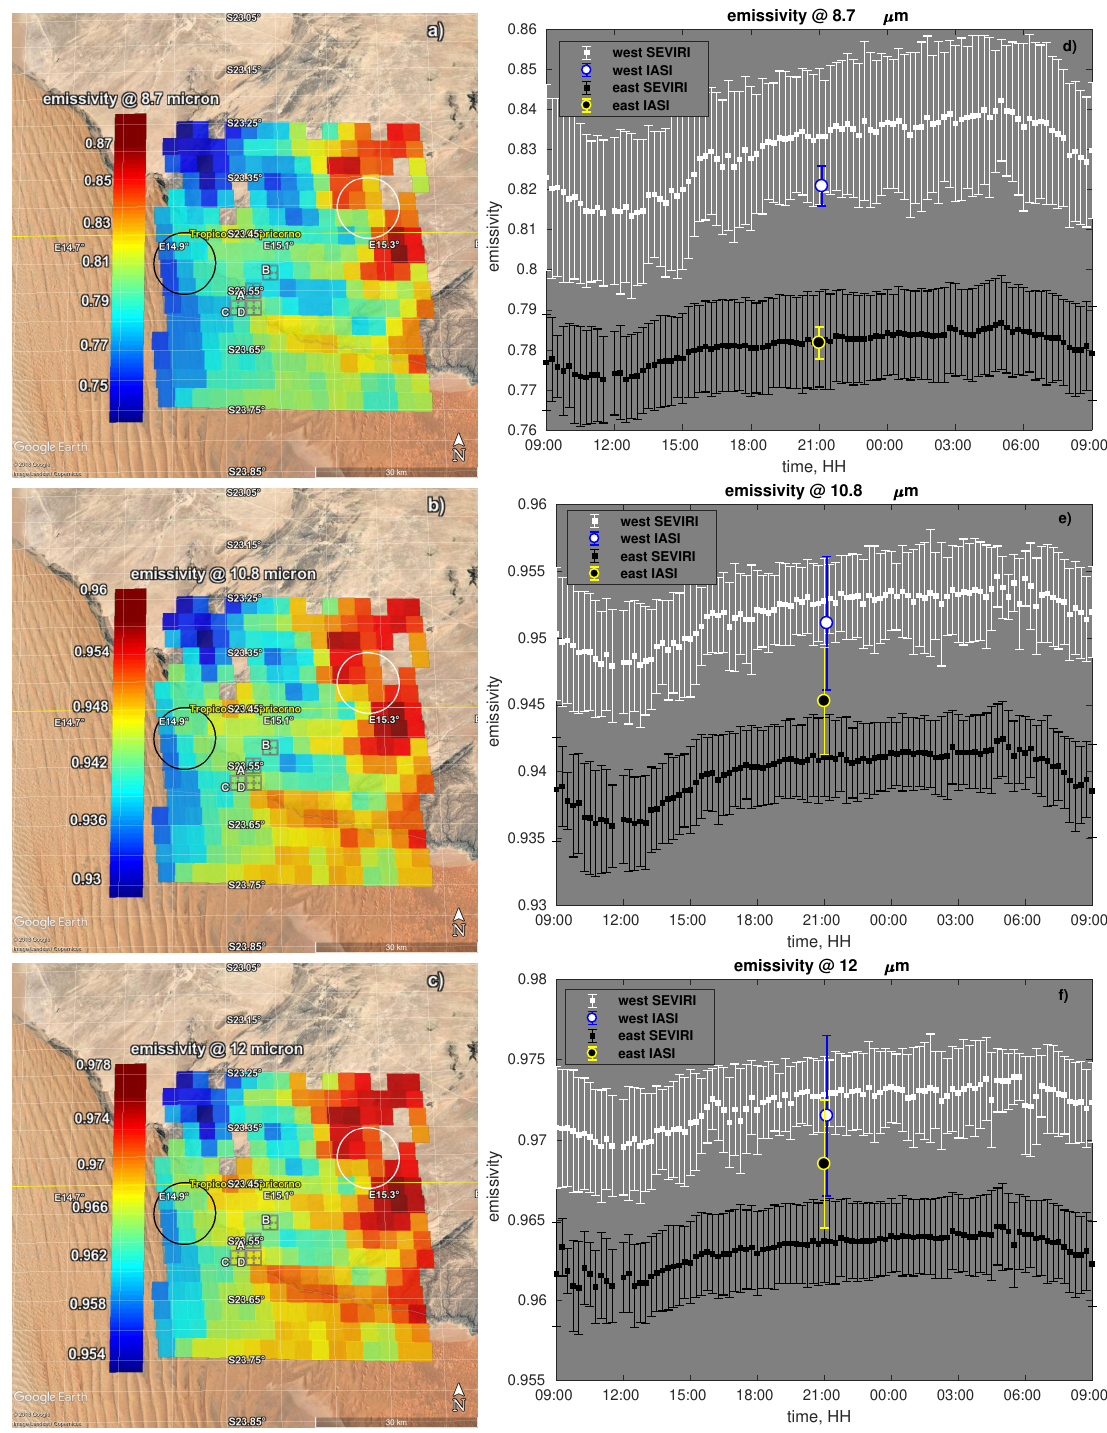
Figure 10. SEVIRI vs IASI emissivity. Panels on the left show the map of SEVIRI retrieved emissivity at 21:00:00 of 22 June 2017. Panels on the right show IASI retrieved emissivity and a time series of co-located SEVIRI retrieved emissivity. Panels ( a , d ) refer to the channel at 8.7 µ m; panels ( b , e ) to the channel at 10.8 µ m; panels ( c , f ) to the channel at 12 µ m. In panels ( d – f ) SEVIRI dots and related error bars represent respectively the mean and the standard deviation of the retrieved emissivity for the SEVIRI pixels inside IASI footprint respectively. The IASI errorbar is the root mean square error of the retrieval computed based on the corresponding emissivity error covariance